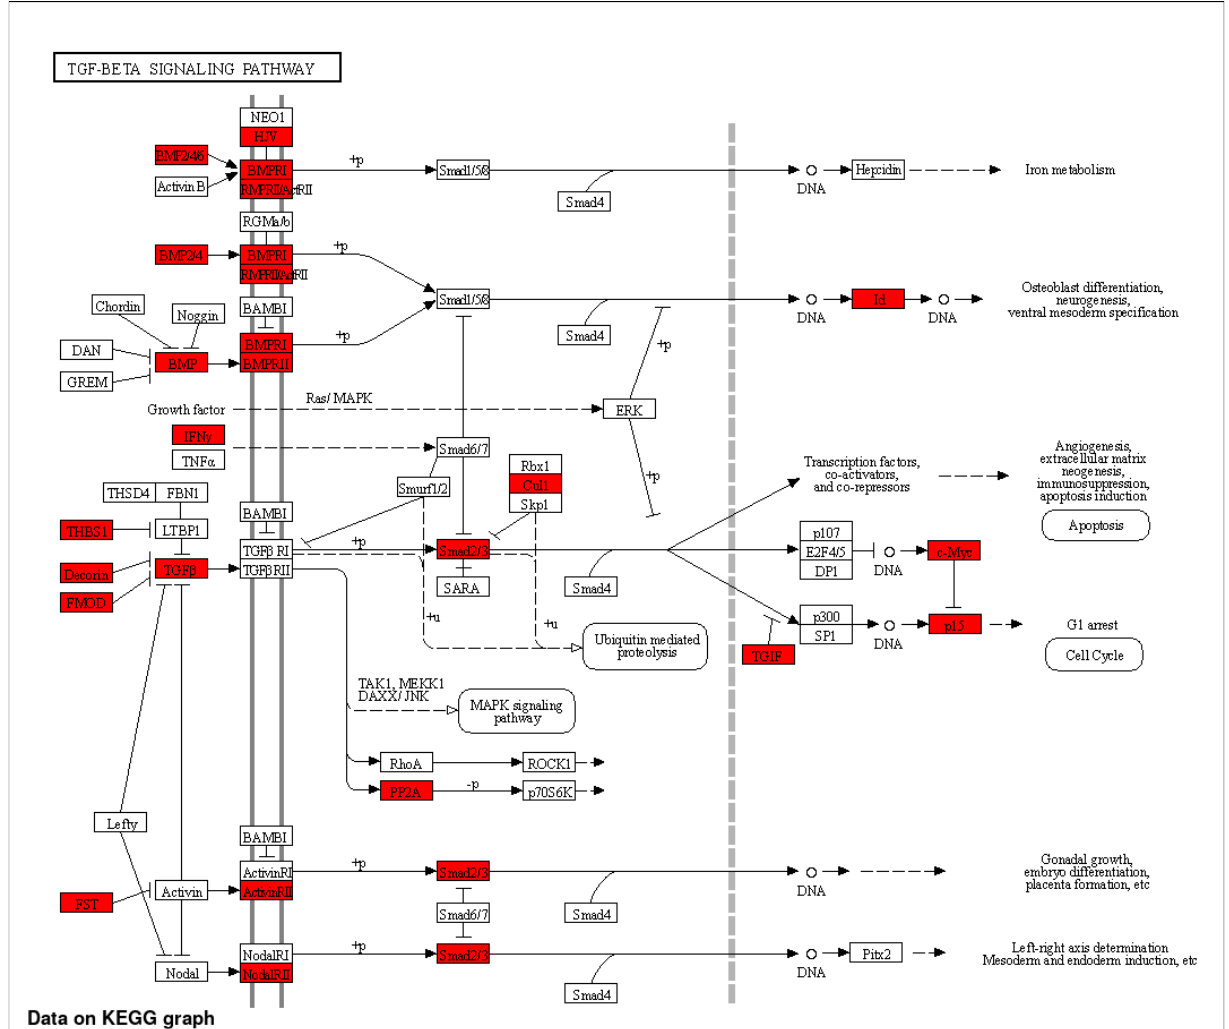
Figure 5. KEGG TGF- β signaling pathway obtained from the repressed differentially CTCF-binding sites (DCBS). Genes from the repressed DCBS are highlighted in red.